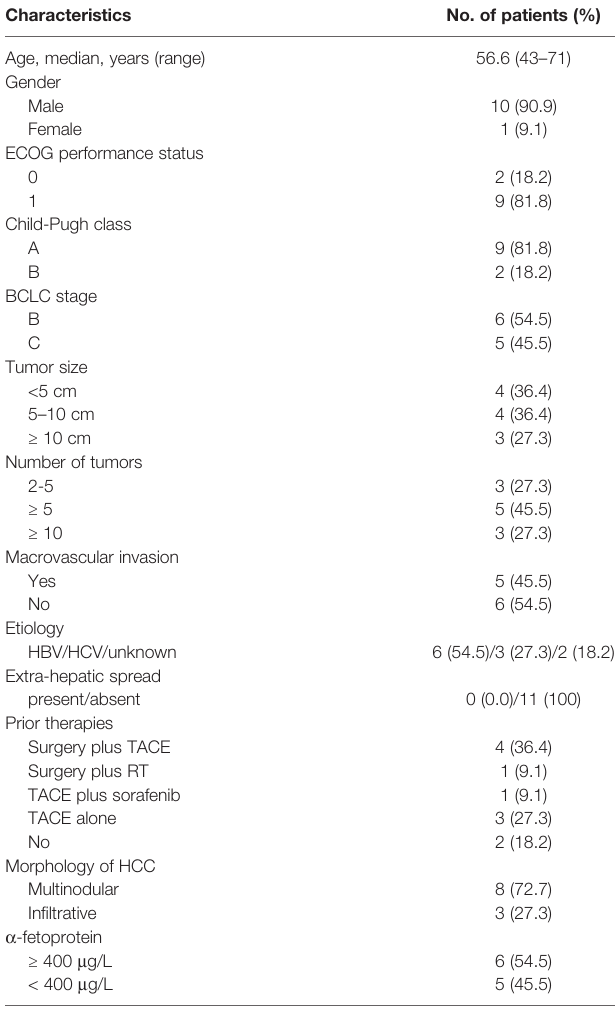
TABLE 1 | Baseline clinical characteristics of patients ( n =